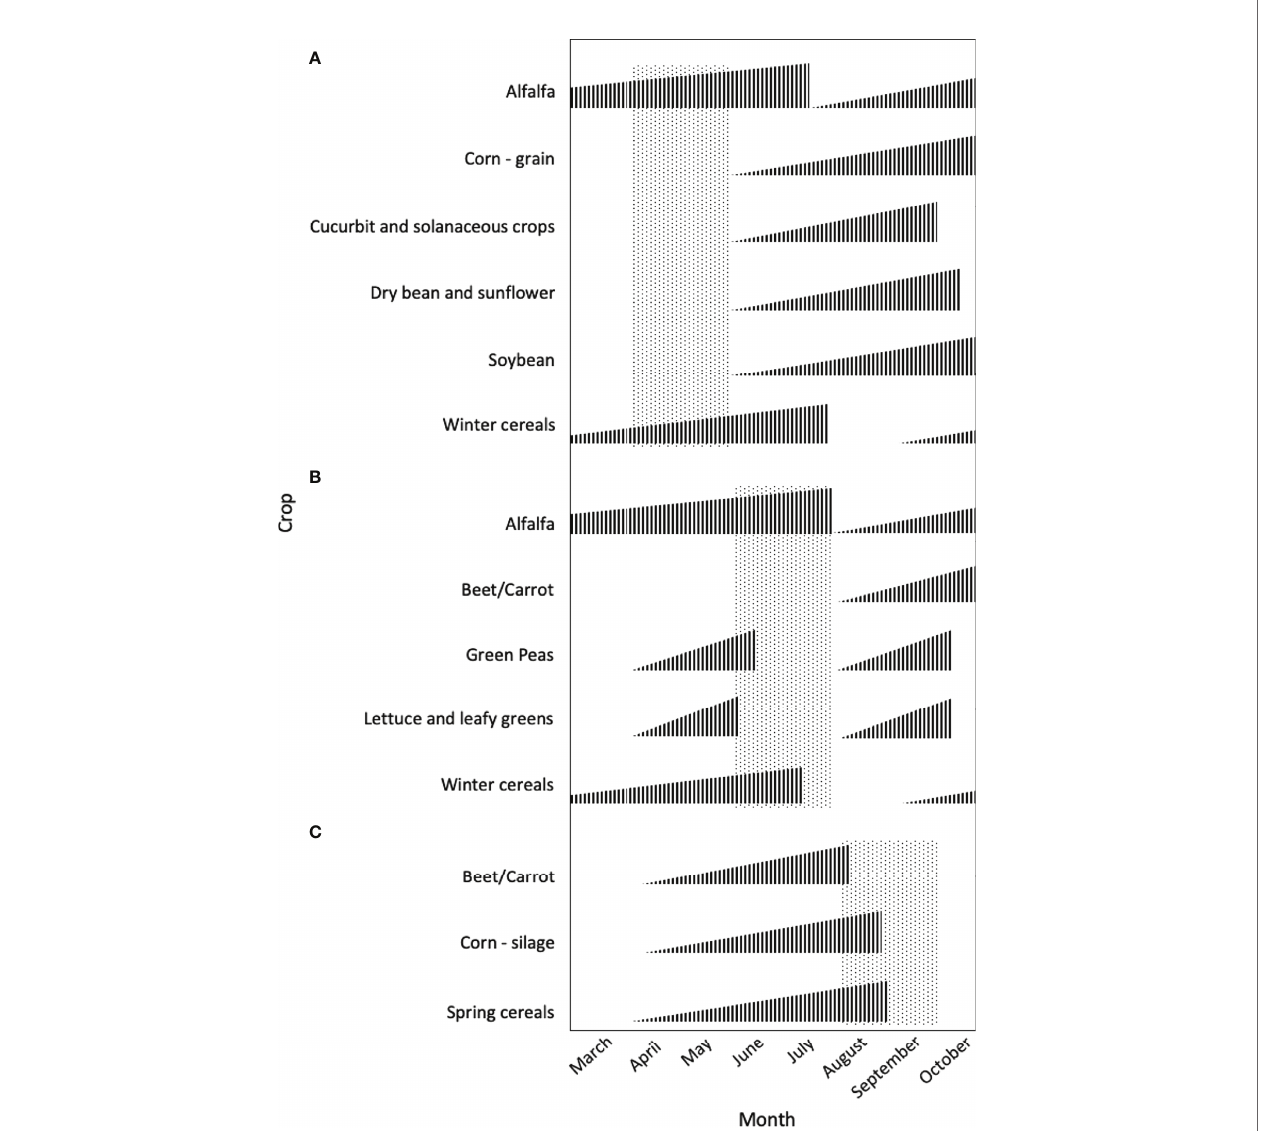
FIGURE 4 | Examples of crops that may be shifted to avoid of peak weed emergence periods occurring in the early ( A , April-May), middle ( B , June-July), or late ( C , August-September) growing season of the cool, temperate climate of Northeast USA. Height of vertical bars represents the relative stage of crop